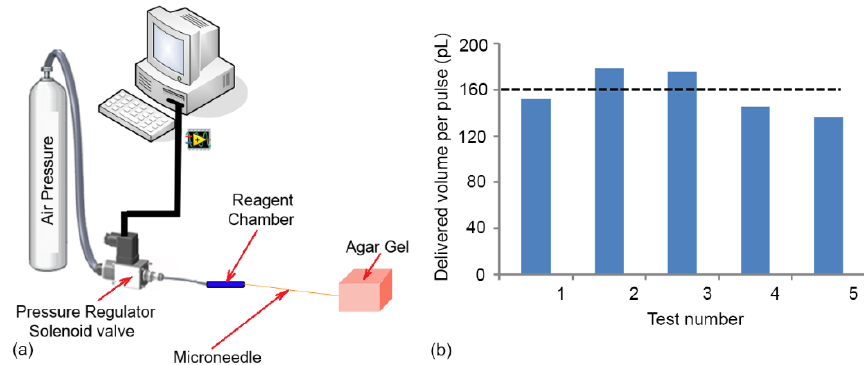
Figure 13. ( a ) Schematic of the experiential setup used to characterize the reagent delivery system. The microneedle (OD = 90 µm, ID = 20 µm, length = 80 mm) connected to the reagent chamber (ID =